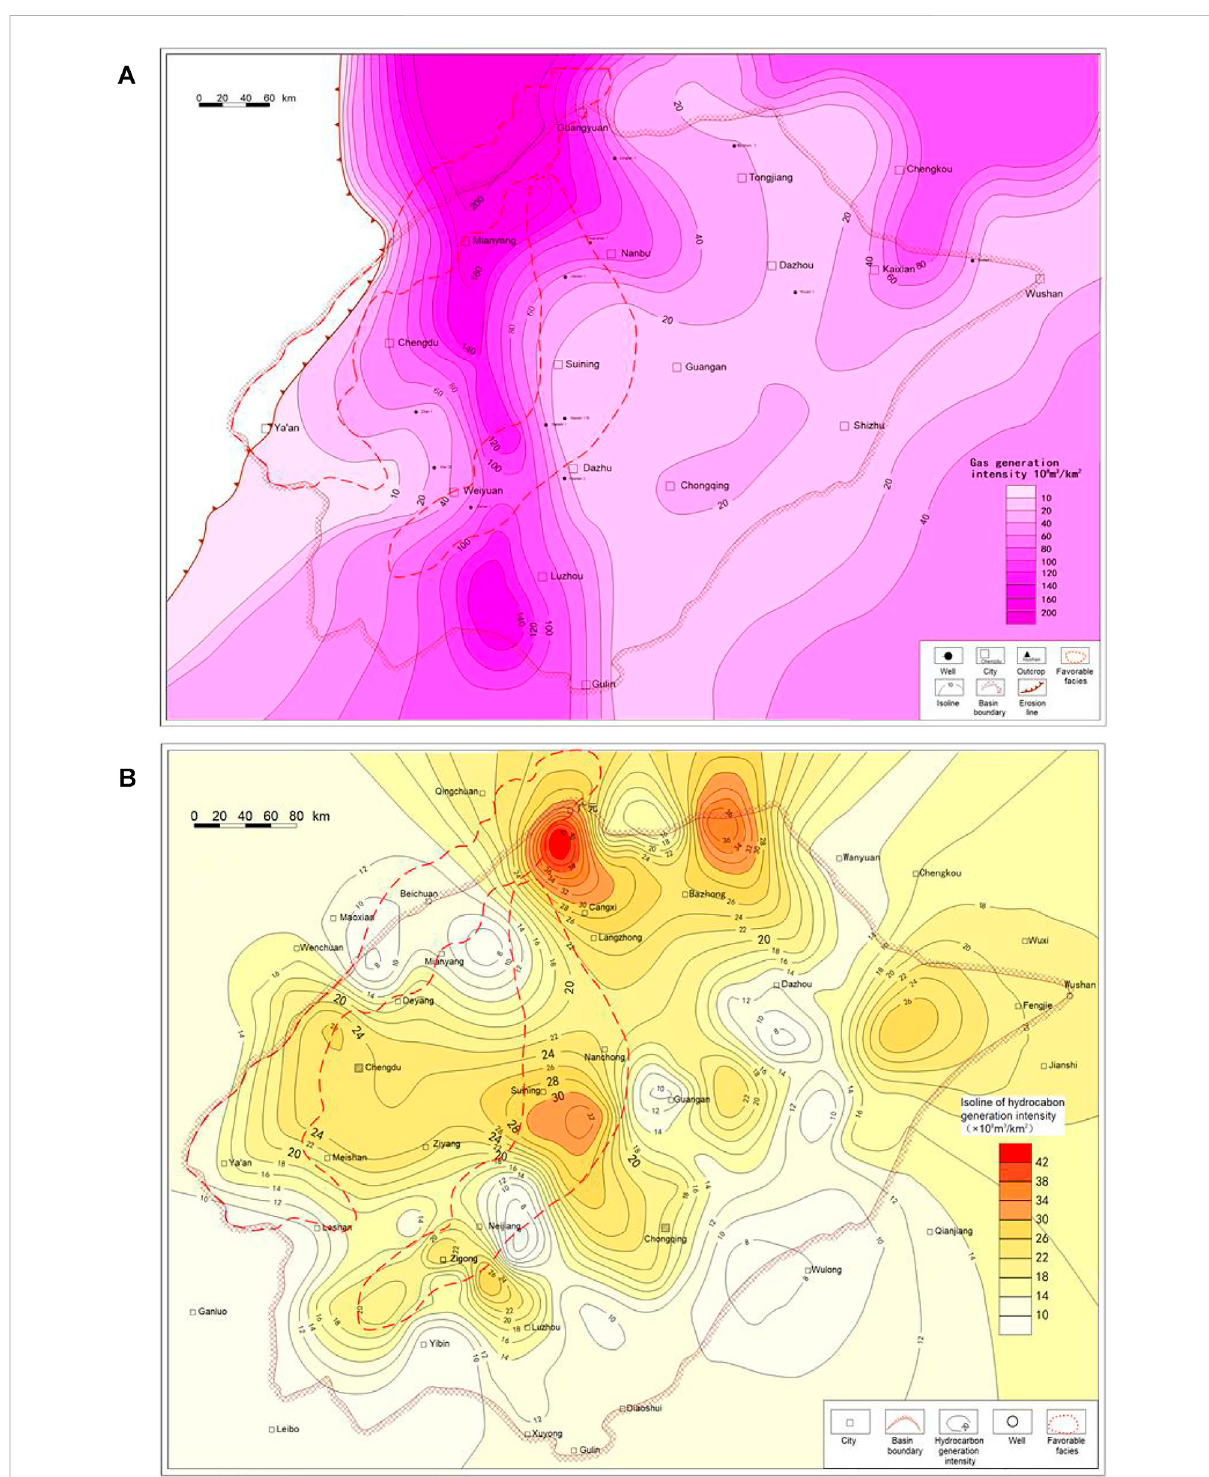
FIGURE 6 Overlapping diagram of hydrocarbon generation intensity of source rocks and favourable facies of the Qixia Formation. (A) Hydrocarbon generation intensity map of the Lower Cambrian source rocks. (B) Hydrocarbon generation intensity map of the Middle Permian source